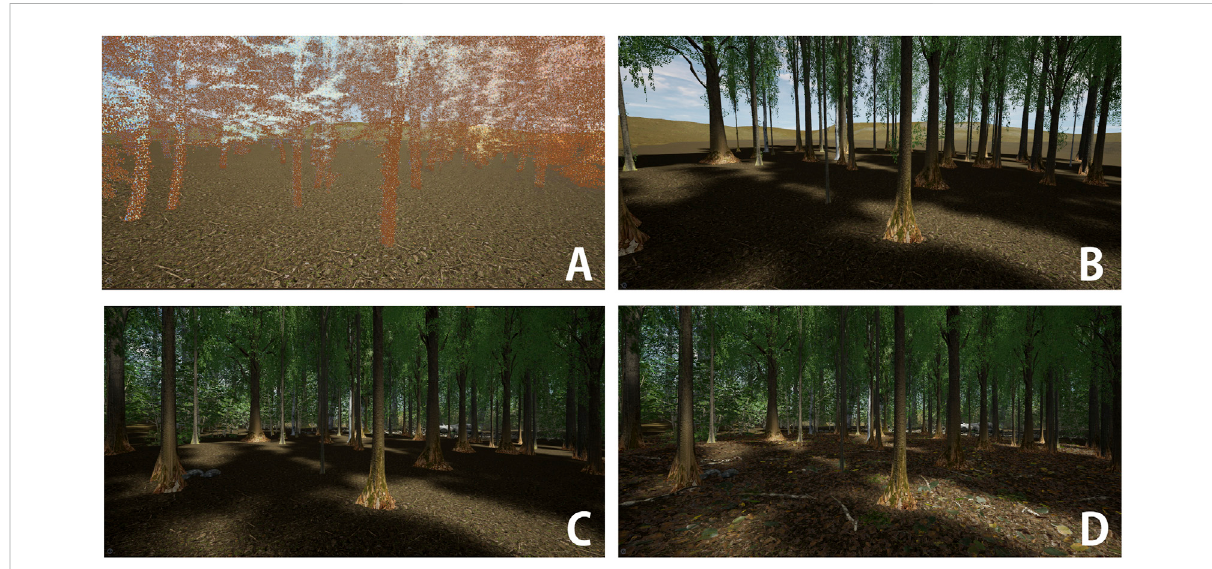
FIGURE 1 Illustrationofthevirtual forestcreationprocess.Sub fi gure (A) showsthelandscapewiththevisualizedlidarpointcloud.Sub fi gure (B) showsthe placements of trees based on lidar detection algorithms. Sub fi gure (C) shows the environment after surrounding vegetation is added to create a feeling of continuous forest, and sub fi gure (D) displays the fi nal environment with forest fl oor and undergrowth